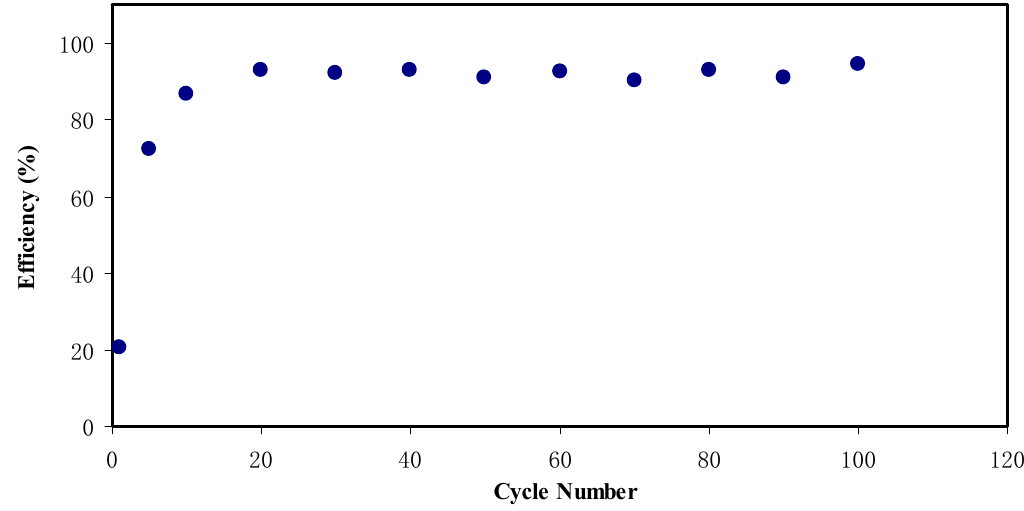
Figure 13. Cycling stability of the EDLC up to 100 cycles.